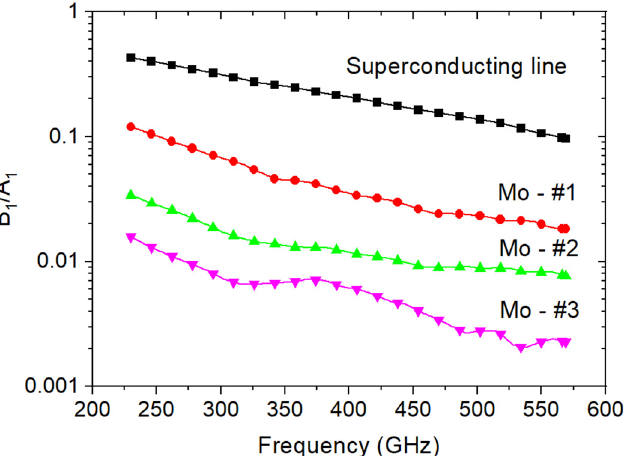
Figure 8. Amplitude of the wave after propagation in the line and reflection from the end normalized to the initial amplitude versus frequency for simulated structures.